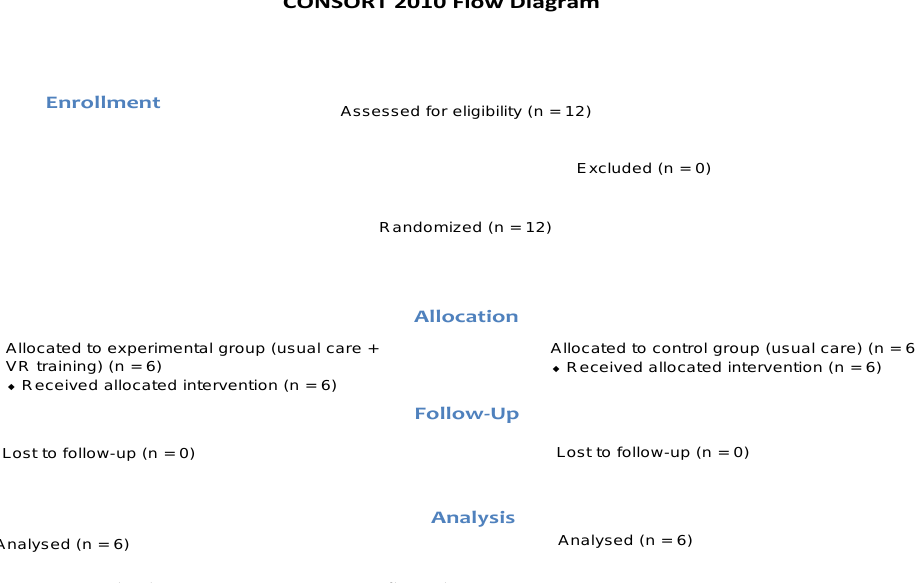
Figure 1. Study design: CONSORT 2010 flow diagram.